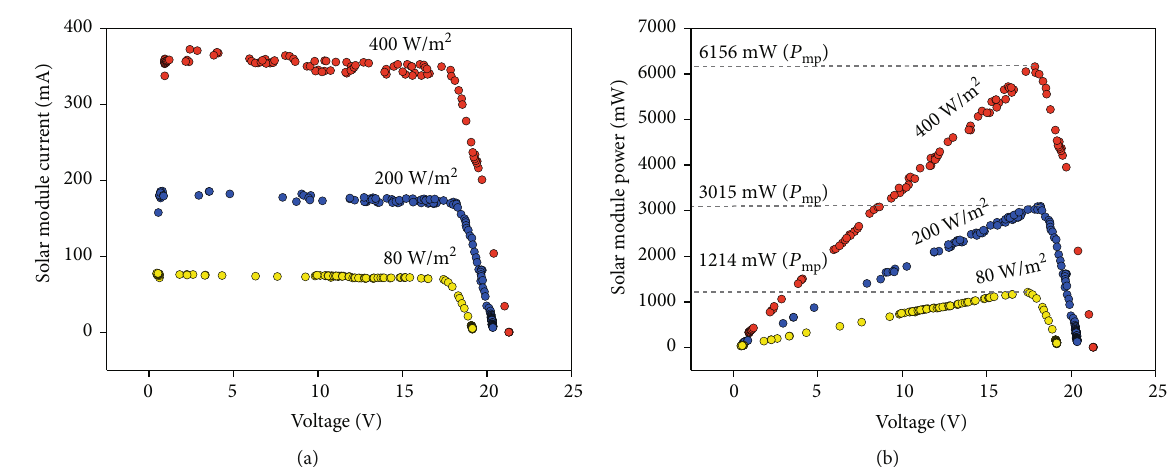
Figure 10: Power test result of the solar module: (a) I ‐ V curve; (b) P ‐ V